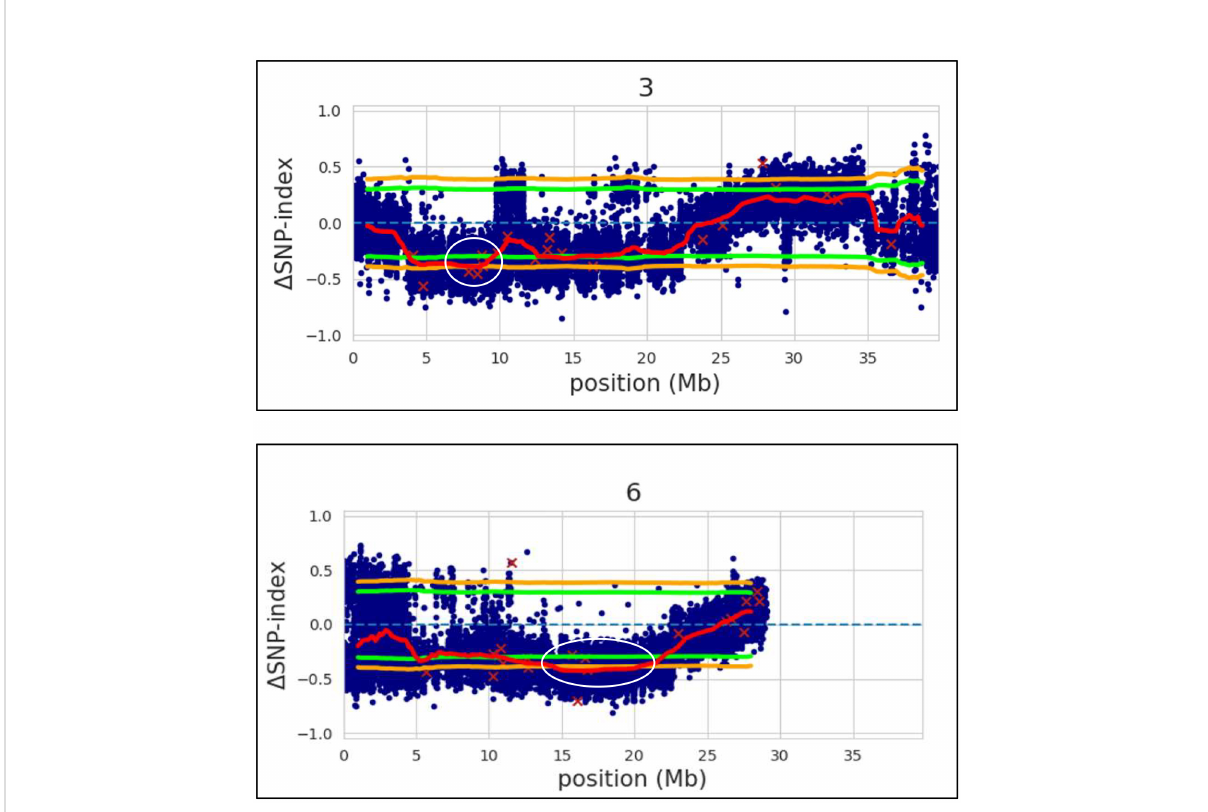
FIGURE 4 D (SNP-index) with statistical con fi dence intervals (orange, 99%; green, 95%). The major QTL identi fi ed on chromosome 6 and a minor QTL region on chromosome 3 of cucumber by QTL-seq (shown in white outline).